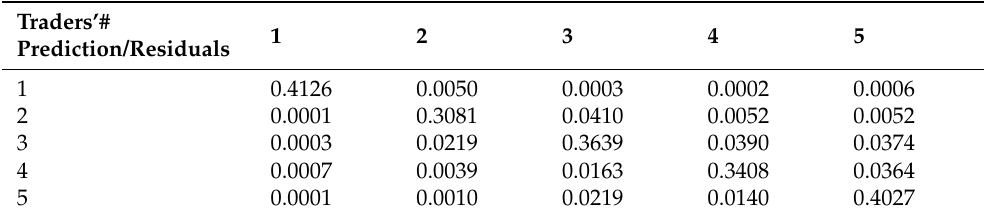
Table 3. Mutual determination of variances (|| ρ ij ||=|| r ij 2 ||) for the regression predictions and the regression residuals.